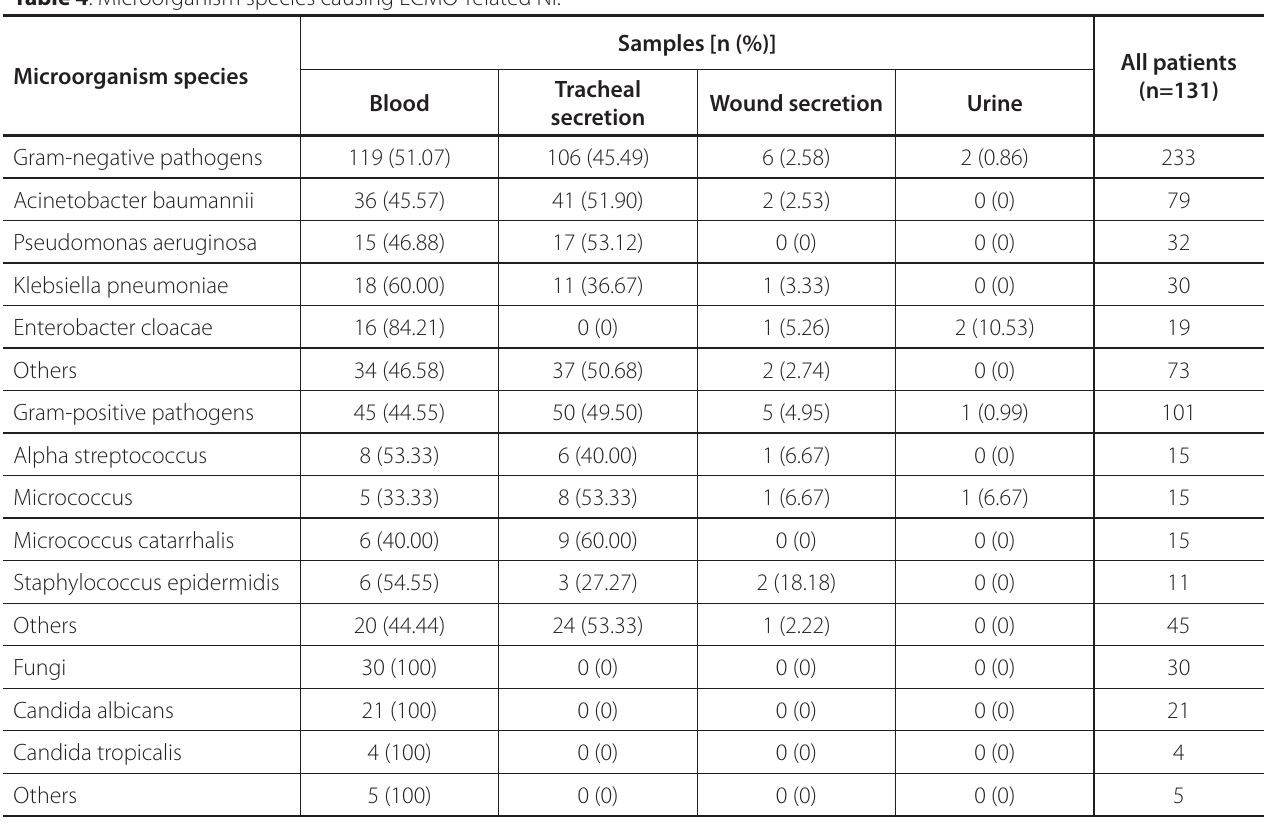
Table 4 . Microorganism species causing ECMO-related NI. Microorganism